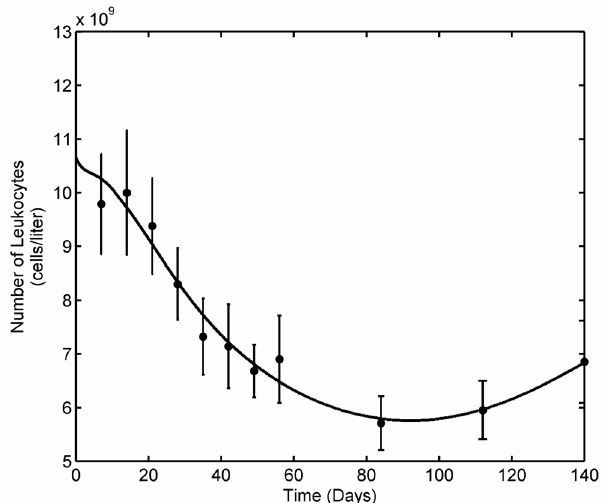
Figure 5. Leukopoiesis model fit to average patient data. Solid dots represent average patient data and curve represent leukocyte model (Eqn. 4) fit. The model mimics the clinical observation during 6- MP treatment; Depletion of leukocytes following 6-MP dosing has been countered by the body’s feed-back mechanism. Error bars represent standard